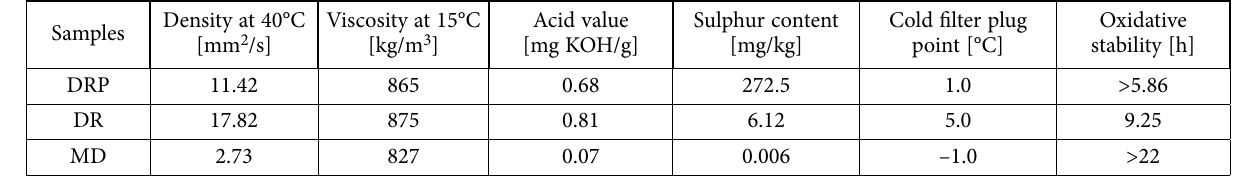
Table 2. Characteristic of mixtures: DRP – volume ratio 40:55:5, DR – volume ratio 45:55 and